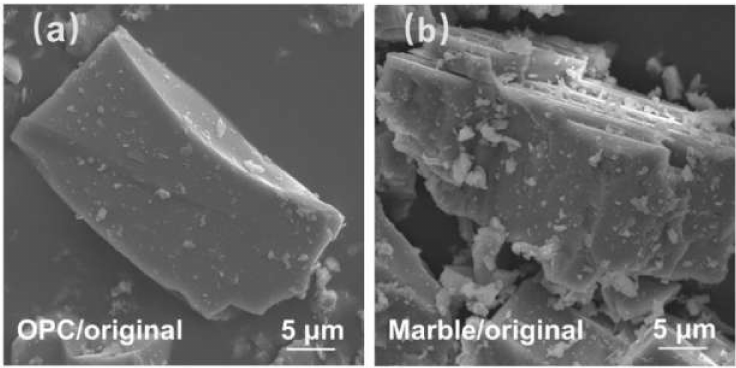
Figure 5. Morphology of OPC ( a ) and marble ( b )